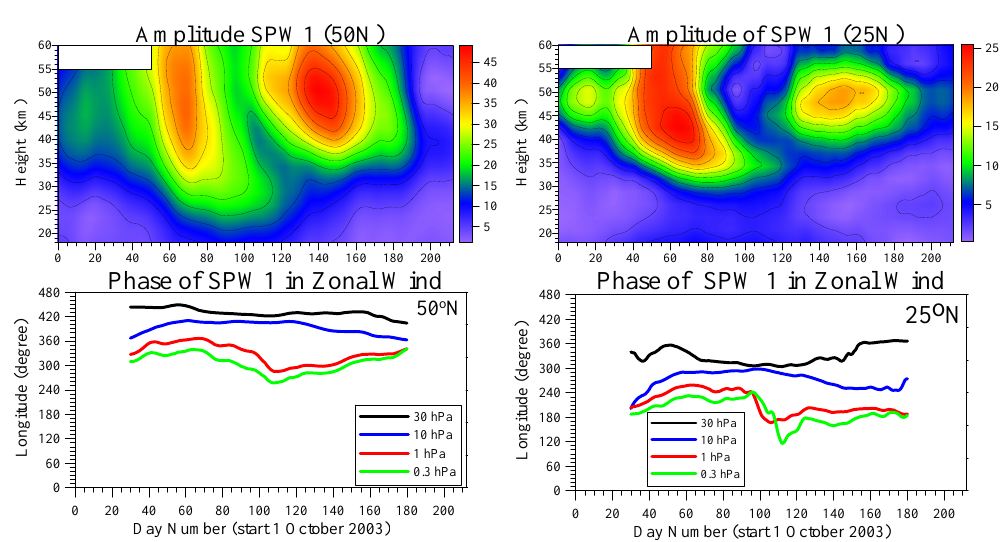
Figure 6 Fig. 6. Height-time cross sections of the SPW1 amplitudes (upper row of plots) and their phases (bottom row of plot) at latitudes of 50 ◦ N (left column of plots) and 25 ◦ N (right column of